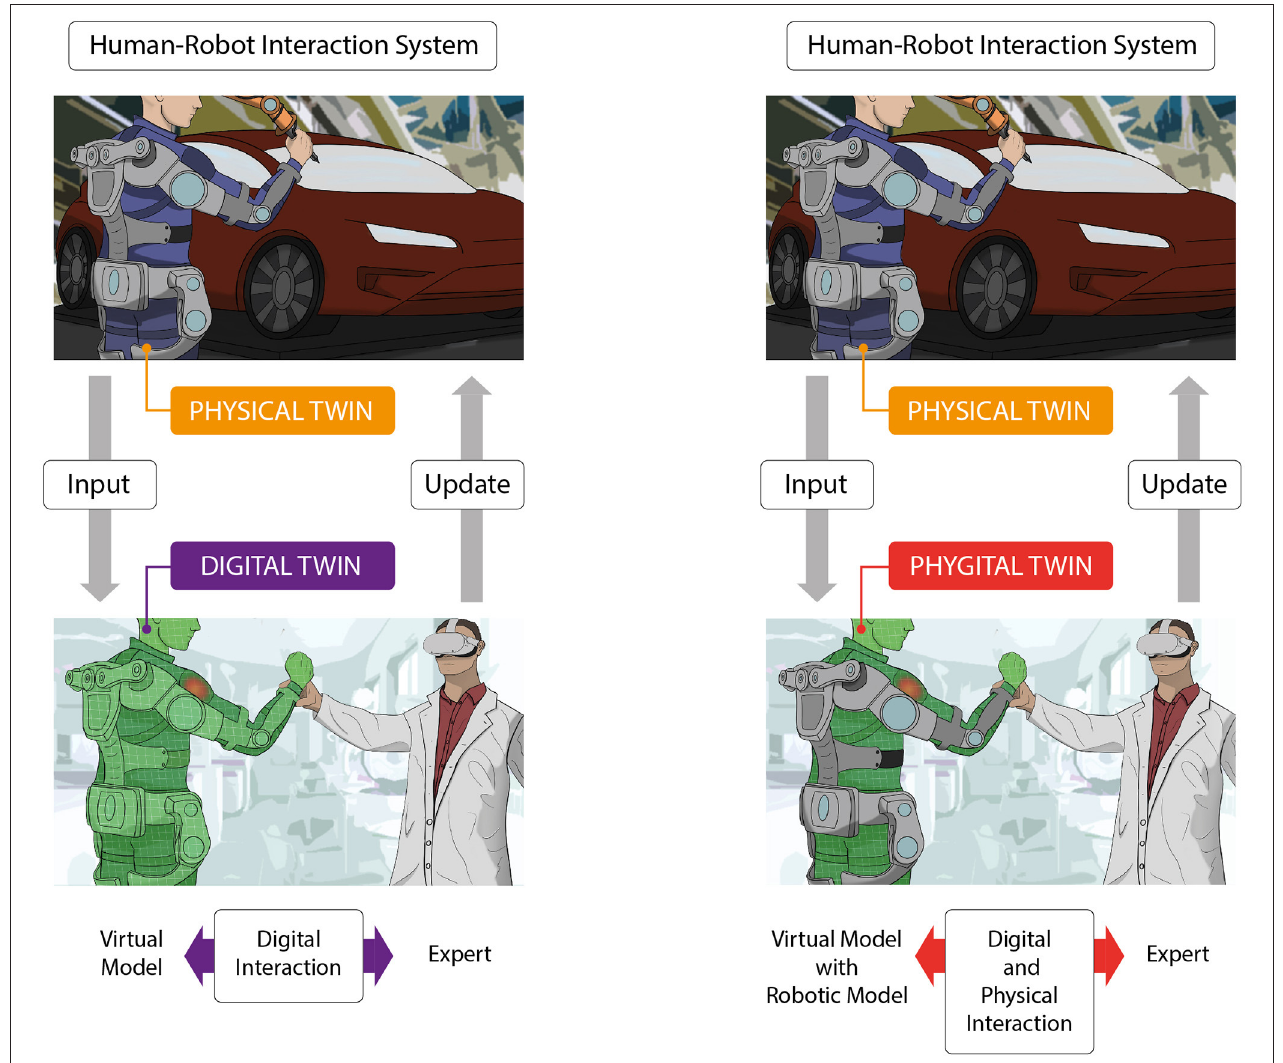
FIGURE 1 | A Physical Twin (PT), based on a human-exoskeleton system in a context of usage, connected (on the left) to its Digital Twin (DT) in green, based on a virtual model of the human-robot interaction (HRI) system, or (on the right) to its Phygital Twin (PDT), based on a holographic human “wearing” a real exoskeleton in a